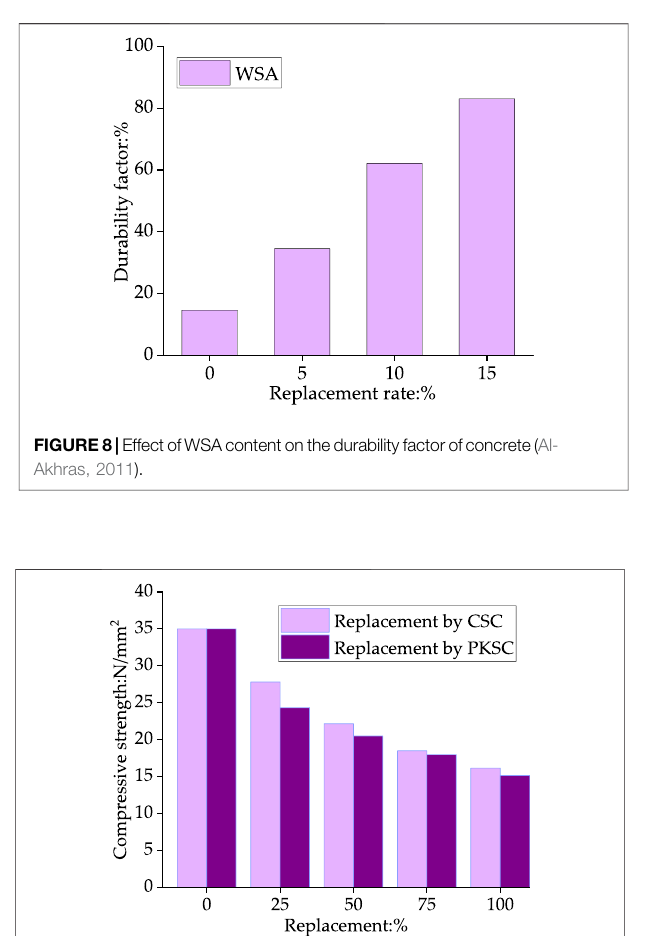
Frontiers in Materials |